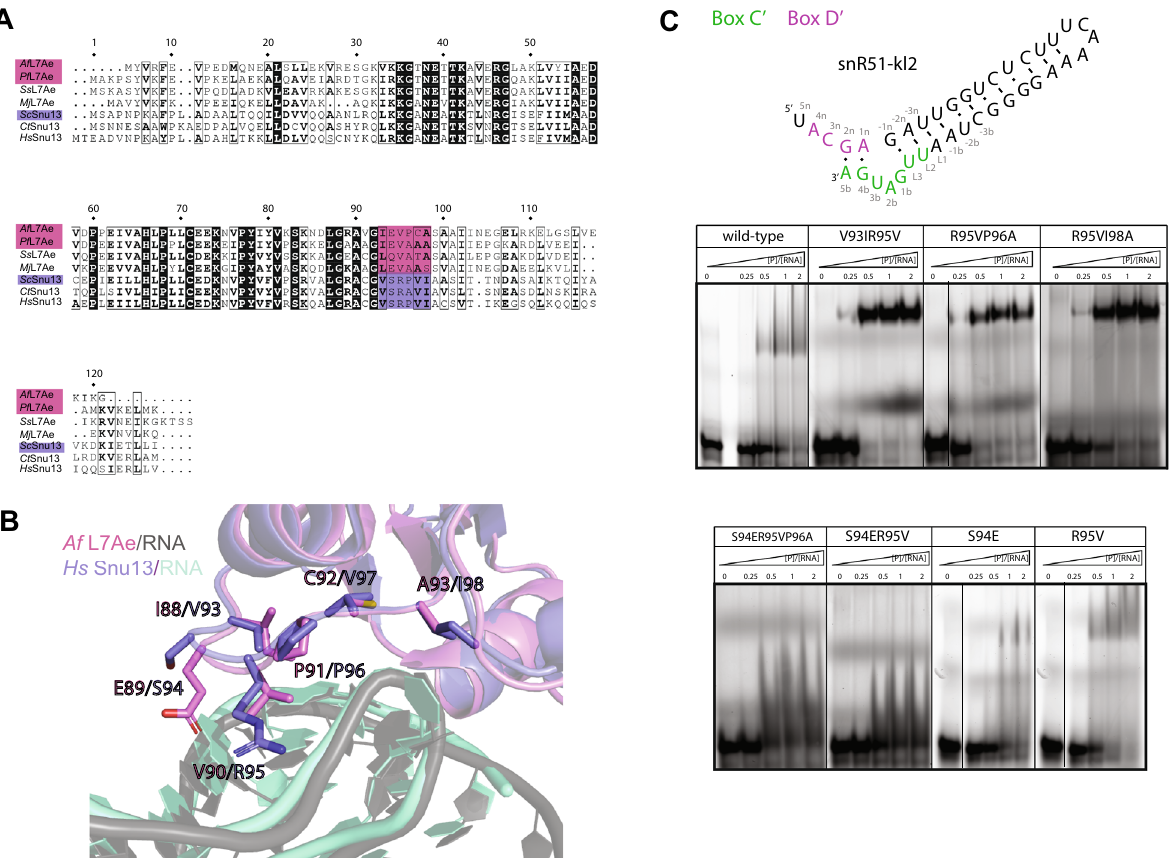
Figure 3. Influence of Snu13 loop 9 on binding affinities for guide RNA. ( A ) Alignment of the primary sequences of archaeal and eukaryotic L7Ae and Snu13 ortholog proteins, showing the poor conservation of loop 9 residues (in pink and purple) from archaea (pink) to eukaryotes (purple). The residue numbering is that of Snu13 from S. cerevisiae . Af – Archaeoglobus fulgidus, Pf – P. furiosus , Ss – S. solfataricus , Mj – M. jannaschi, Sc – S. cerevisiae Ct – C. thermophilum , Hs – H. sapiens . ( B ) Overlay of the structure of Af L7Ae (pink) in complex with a canonical k-turn RNA (gray) (PDB code: 1RLG) and the structure of Hs Snu13 (slate) in complex with the U4 k-turn RNA (turquoise) (PDB code: 1E7K). ( C ) Electrophoretic mobility shift assays of 5’-Cy5 fluorescently labeled snR51-kl2 RNA in the presence of Sc Snu13. The predicted secondary structure